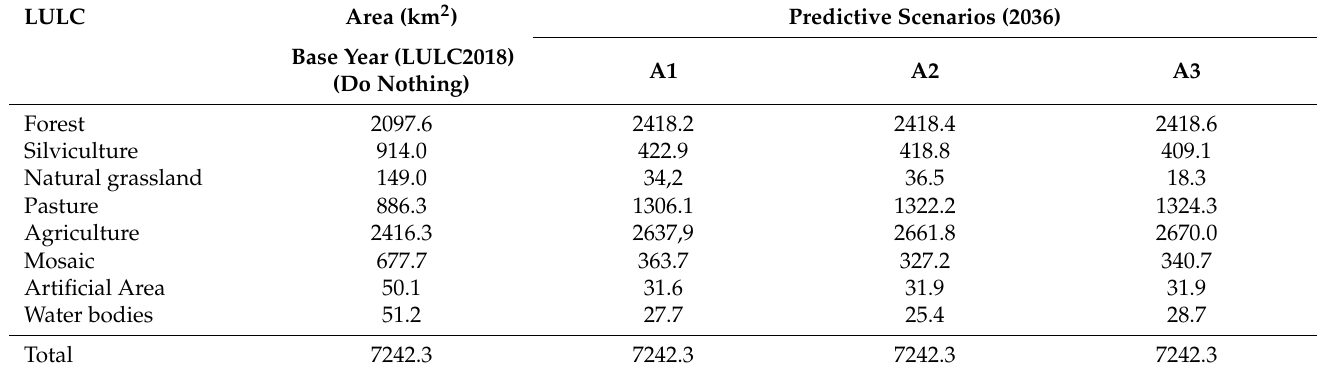
Figure 4. Scenario A—LULC evolution trends of the predictive scenarios for 2036—Chapecó River EC/SC—Brazil. EC/SC—Brazil. Table 8. LULC evolution trends of the predictive scenarios A. Table 8. LULC evolution trends of the predictive scenarios